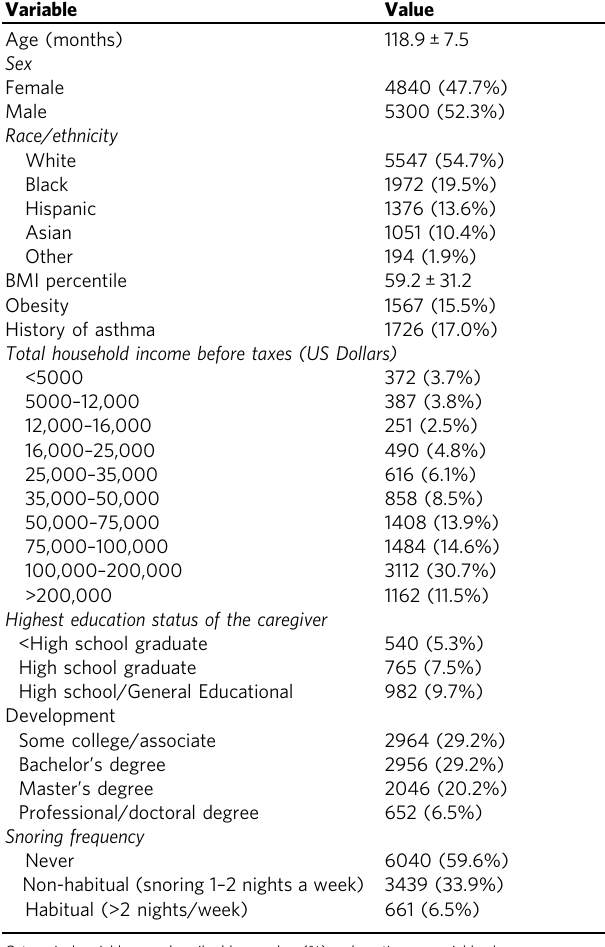
Table 1 Baseline characteristics of the Adolescent Brain Cognitive Development Study ( n =